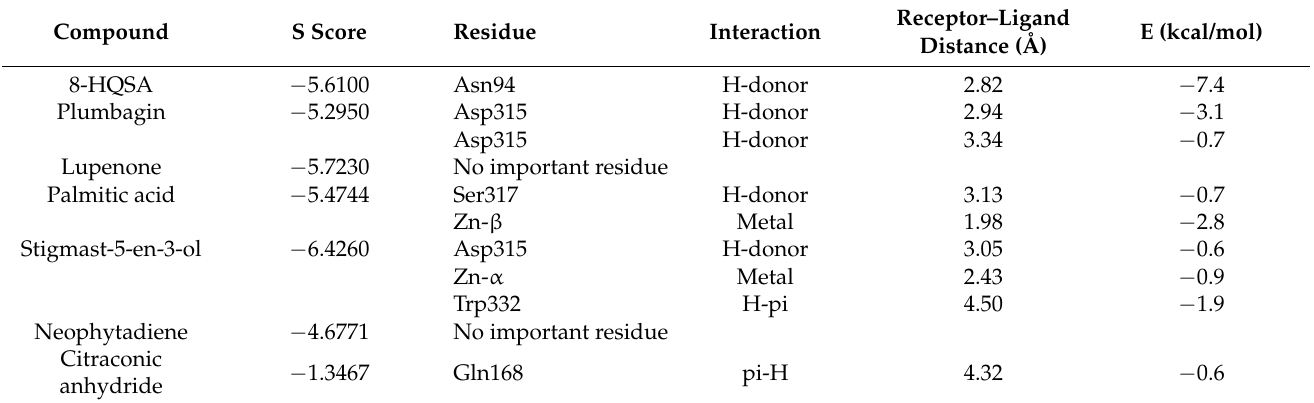
Table 2. Results of the docking studies against